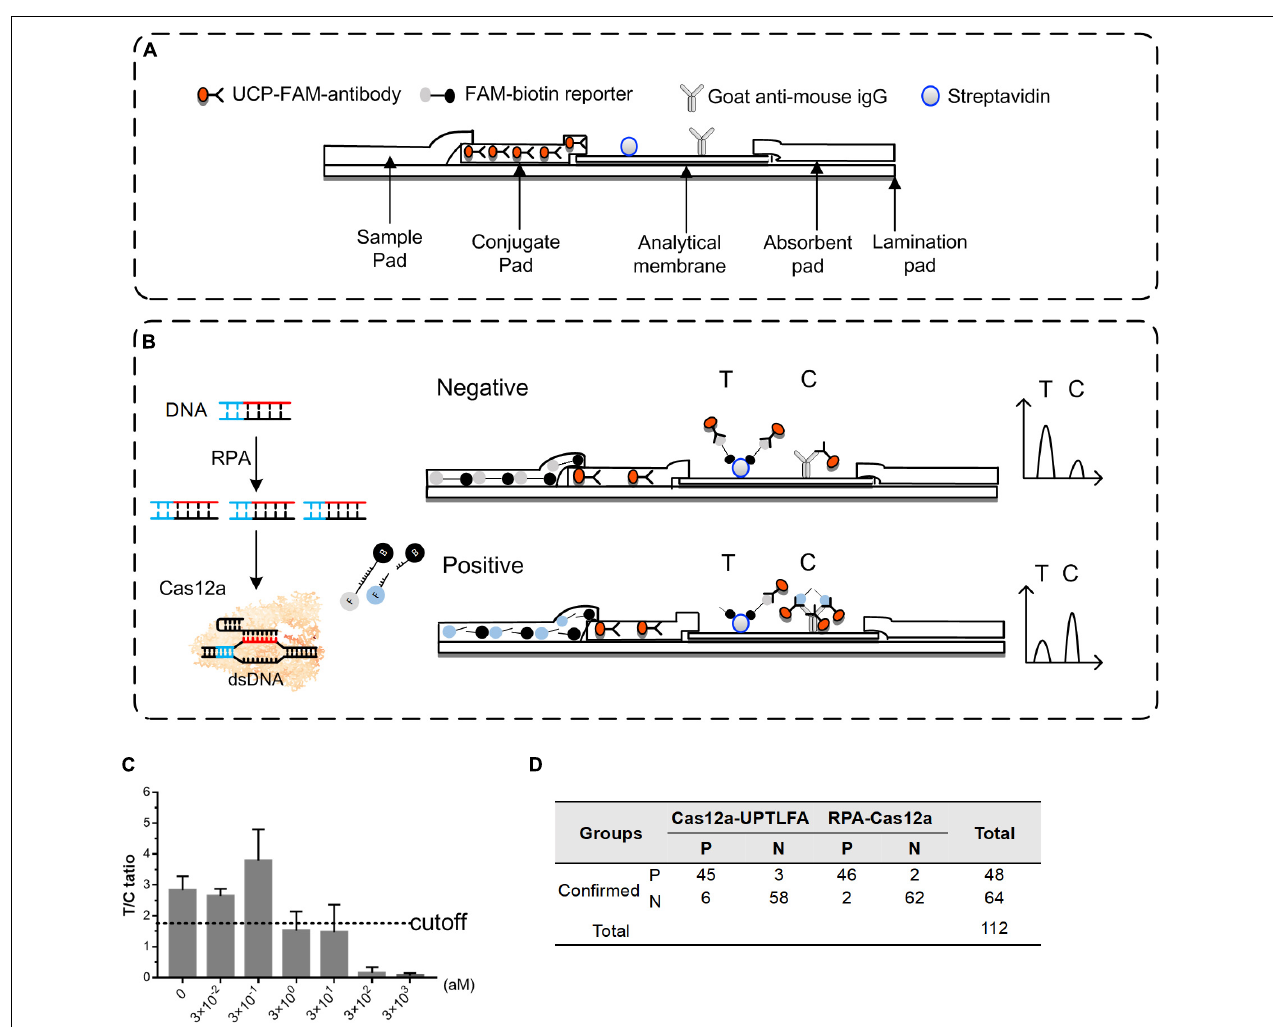
FIGURE 5 | Performance of Cas12a-UPTLFA on detection of the Y. pestis genomic DNA or Y. pestis bacteria in the spiked blood samples. (A) Components of the Cas12a-UPTLFA platform. The sample pad, conjugation pad, analytical membrane, and absorbent pad were mounted on a lamination card with proper overlaps. All antibodies for detection were fixed in advance, including the UCP-labeled with anti-FAM antibody in the conjugation pad, streptavidin for the T line, and goat anti-mouse IgG for the C line. (B) Cas12a-UPTLFA detection relies on the cleavage of a FAM-biotin-labeled ssDNA reporter by the collateral activity of the Cas12 enzymes upon target recognition, allowing the detection on UPT strips. (C) Detection results of Y. pestis genomic DNA samples at concentration ranging from 3 × 10 − 2 to 3 × 10 3 aM. Data are represented as mean with SD ( n = 3). (D) The table shows the summarized results for 112 blood samples detected by Cas12a-UPTLFA platform and RPA-Cas12a fluorescent read-out assay. P, the number of positive samples; N , the number of negative samples; RPA, recombinase polymerase amplification; UPT, up-converting phosphor